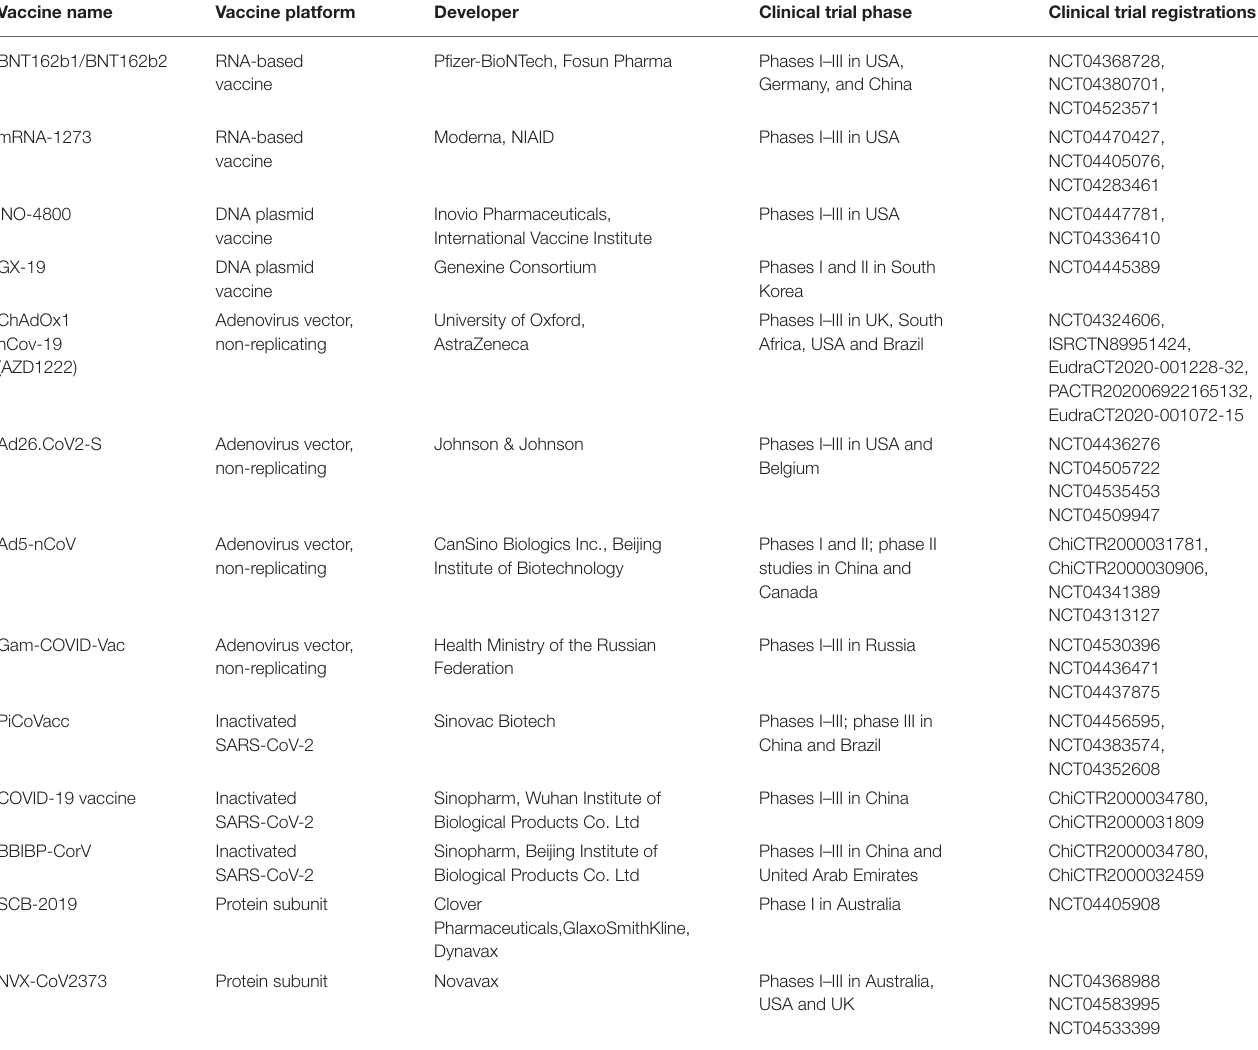
TABLE 4 | Major COVID-19 candidate vaccine platforms in clinical evaluation (Produced with permission